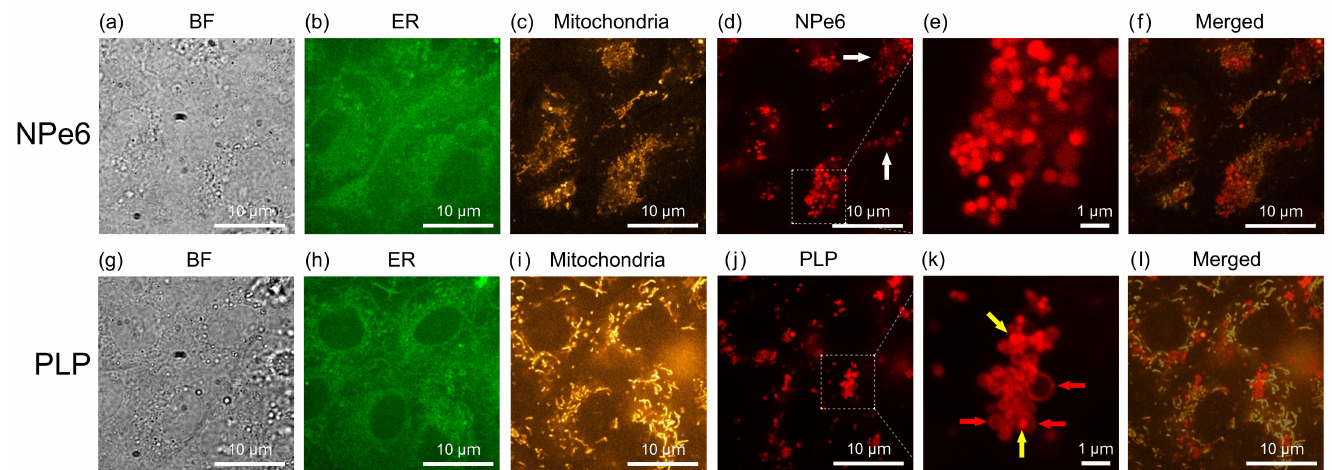
Figure 1. Confocal microscopy observation of RGK1 cells after NPe6 or PLP was added and al- lowed to stand for 24 h. ( a , g ) Bright field (BF) images, ( b , h ) endoplasmic reticulum (ER) fluores- cence images, ( c , i ) mitochondria fluorescence images, ( d , j ) NPe6 and PLP fluorescence images and ( e , k ) their magnified views, and ( f , l ) merged images of ( c , d ), and ( i , j ), respectively. ER-Tracker™ Green (Invitrogen™) and MitoTracker™ Orange CMTMRos (Invitrogen™) were used for fluorescence staining of ER and mitochondria, respectively. After adding these fluorescent probes together in a sample with standing of 24 h after doping NPe6 or PLP, and leaving the mixture for 30 min, measure- ments were carried out while changing the excitation light and filters. Then, PDT was performed to observe the distributions of NPe6 and PLP. As shown in Figure 1e,k, NPe6 and PLP accumulated in granular substances with a diameter of about 200 nm–1 µ